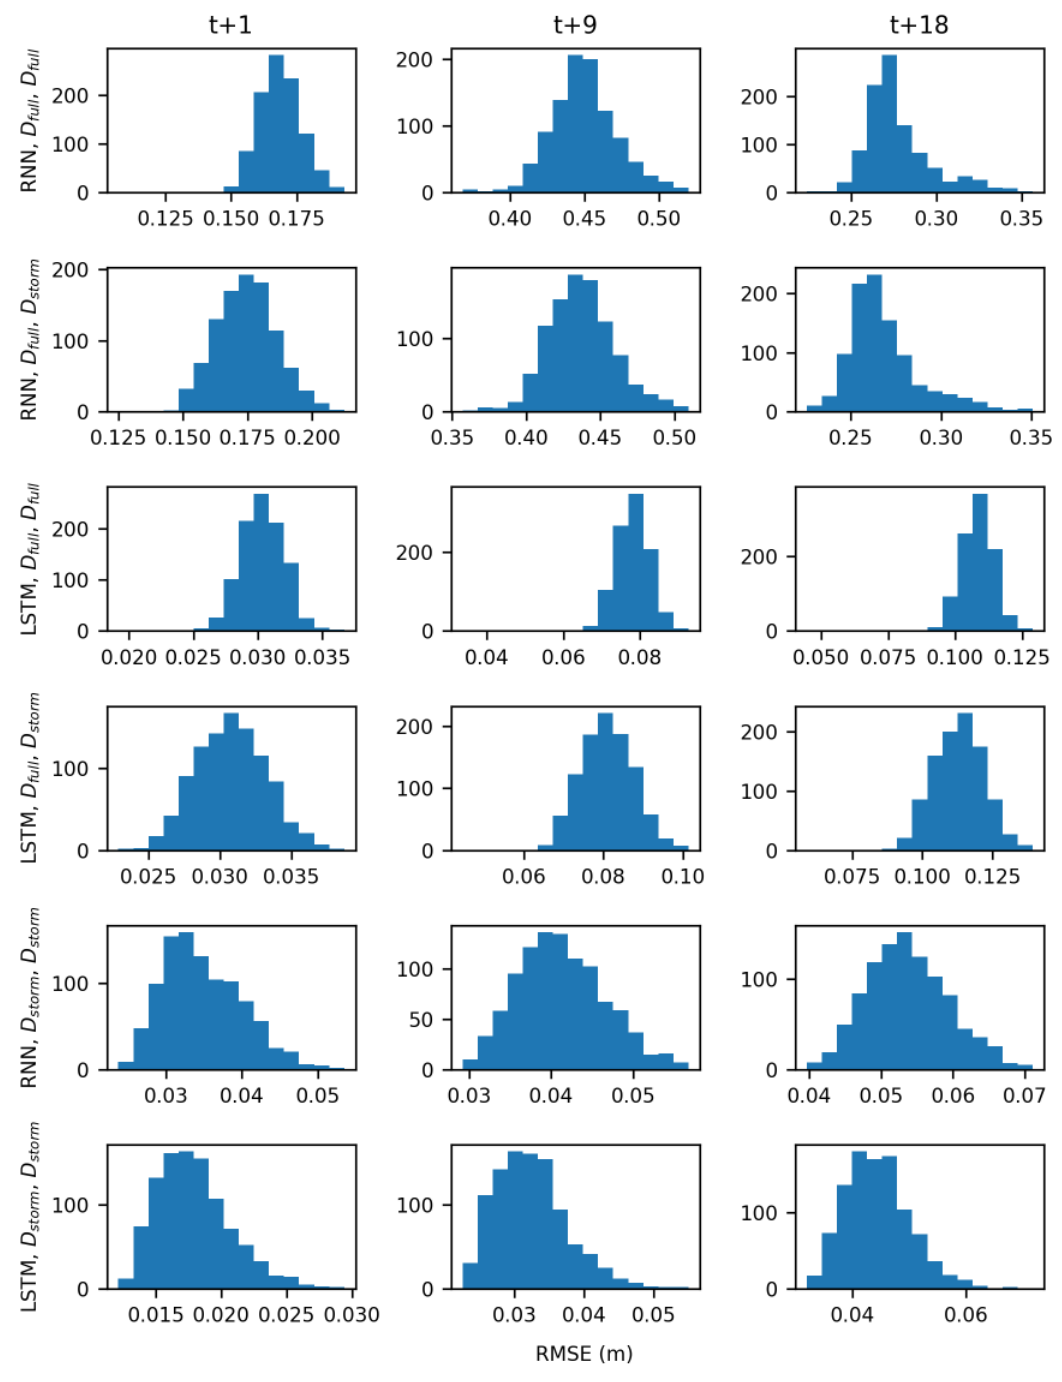
Figure A6. RMSE distributions for GW6 using observed data. Columns represent the forecast horizons t + 1, t + 9, and t + 18. Rows are specified as model type, training data, and testing data.